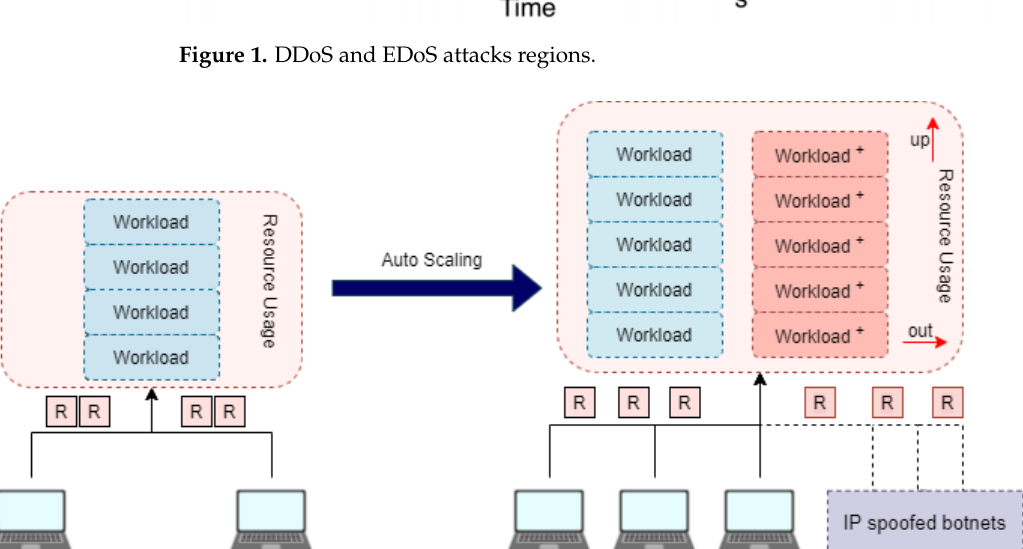
Figure 2. Auto-scaling triggered by EDoS